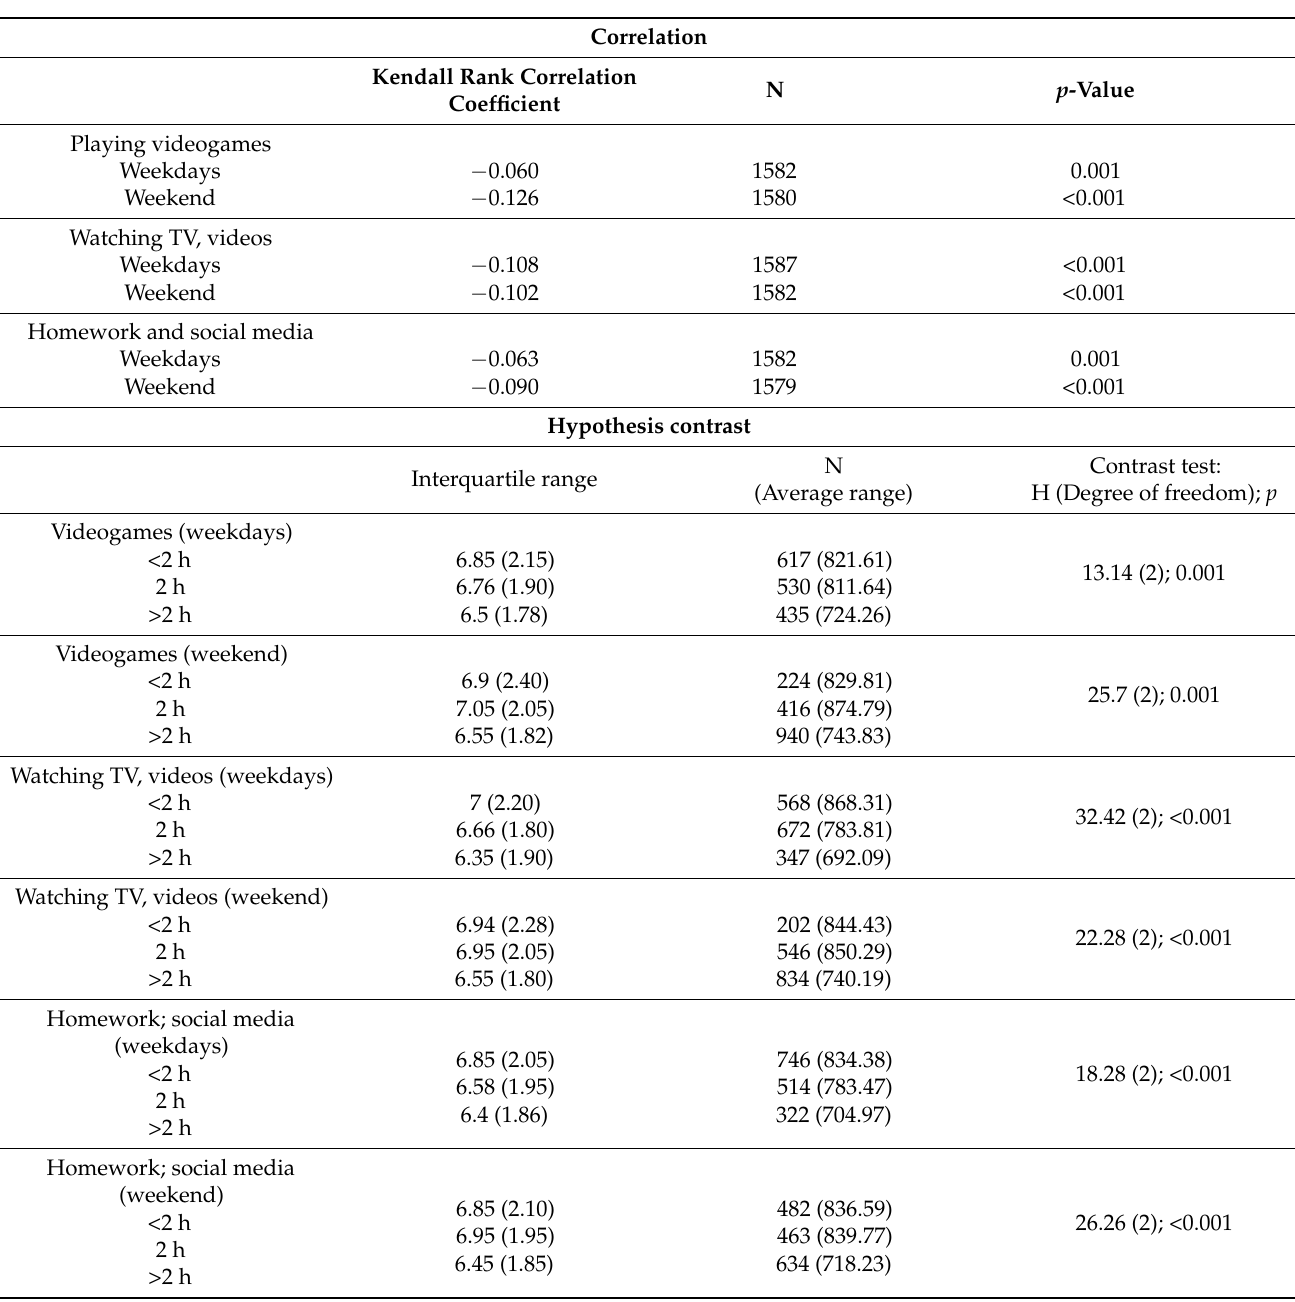
Table 4. Relationship between physical activity and academic